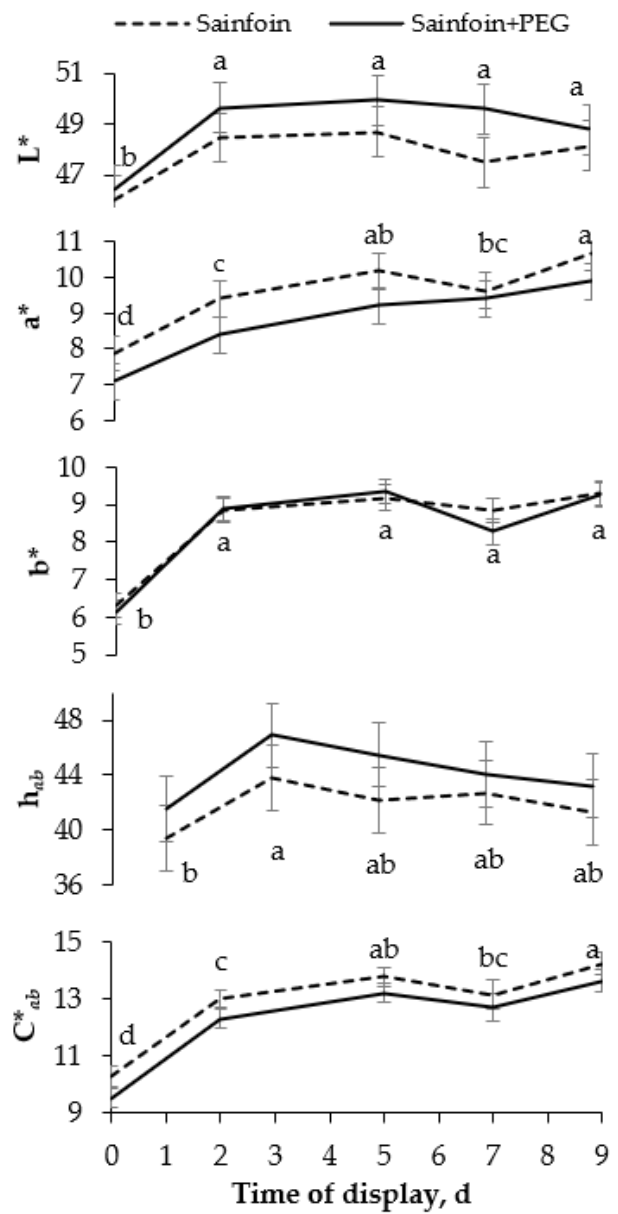
Figure 1. Evolution of instrumental color [lightness (L*), redness (a*), yellowness (b*), hue angle (h ab ), and chroma (C* ab )] of meat of suckling lambs according to the presence of proanthocyanidins (PAC) in their dams’ diet. Within a parameter, different letters mean differences at p < 0.05 among days. Vertical bars indicate the standard error of the